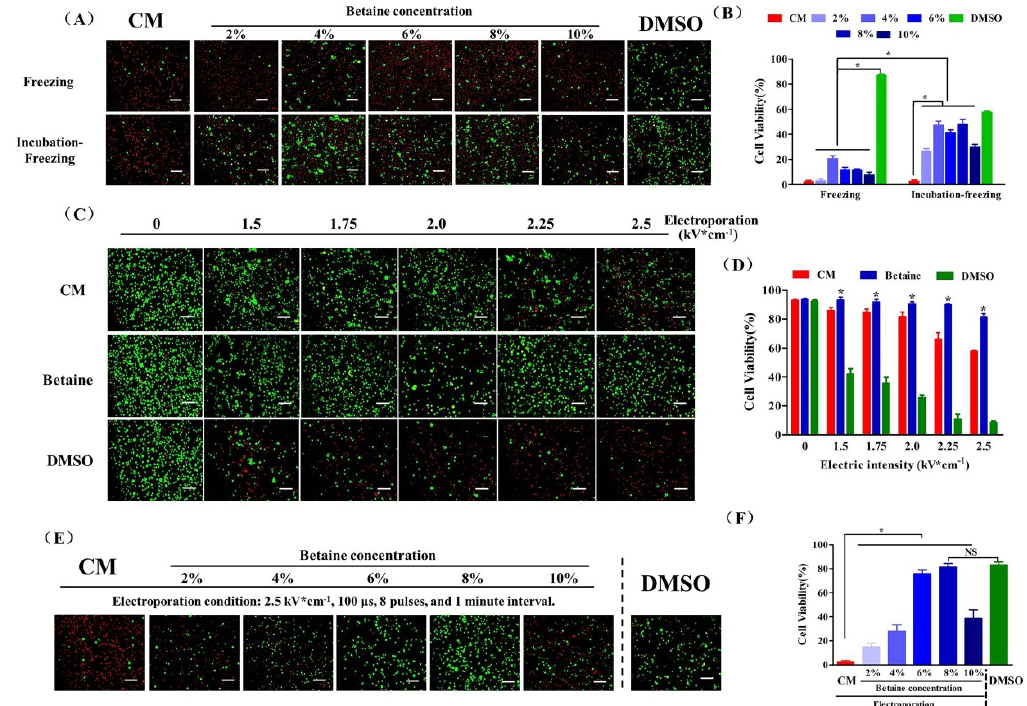
Figure 2. UCMSC cryopreservation. ( A ) Fluorescence images and ( B ) cell survival rate of UCMSCs cryopreserved using culture medium (CM), 2–10% betaine solution (betaine), or 10% DMSO solution (DMSO). ( C ) Fluorescence images and ( D ) cell survival rate of UCMSCs electroporated with culture medium (CM), 8% betaine solution ( w / v ) (Betaine), or 8% DMSO ( v / v ) (DMSO) as buffer in the range of electric intensity from 0 to 2.5 kV × cm − 1 . *: Betaine group compared with culture medium group and DMSO group. ( E ) Fluorescence images and ( F ) cell survival rate of UCMSCs recovered from B–E cryopreservation (CPA solution: culture medium, CM; 2–10% betaine solution, Betaine; Electroporation condition: 2.25 kV × cm − 1 , 100 μ s, 8 plus and 1 min interval) or DMSO-based cryopreservation (DMSO). Green, live cells; red, dead cells. Scale bar = 200 μ m. Value = mean ± standard deviation, n = 3. * p < 0.05, NS: no significance.